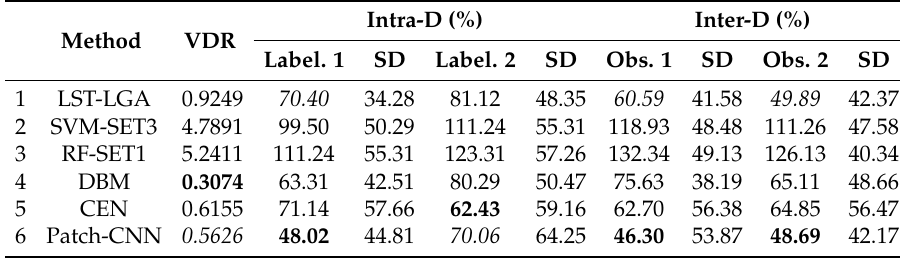
Table 6. Volume difference ratio (VDR) and volumetric disagreement (D) with observers’ measurements for LST-LGA, SVM-SET3, RF-SET1, DBM, CEN and patch-CNN. Near zero of VDR score is better. Whereas, lower score of D in Label. 1, Label. 2, Obs. 1 and Obs. 2 is better. Values in bold are the best score for D evaluation whereas values in italic are the second-best score.